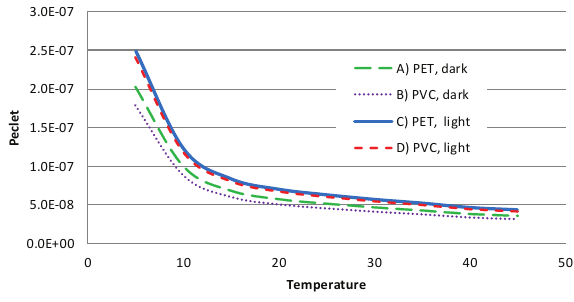
Figure 3: Influence of temperature on Peclet number for various storage materials and conditions.